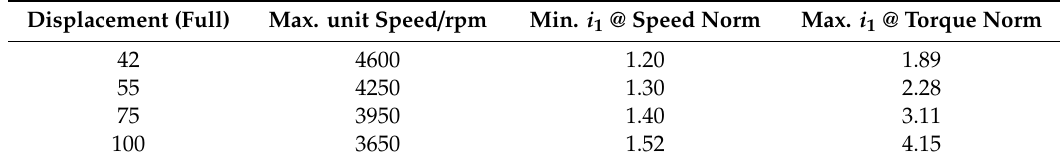
Table 6. PST Unit 1 selection lookup table [16].